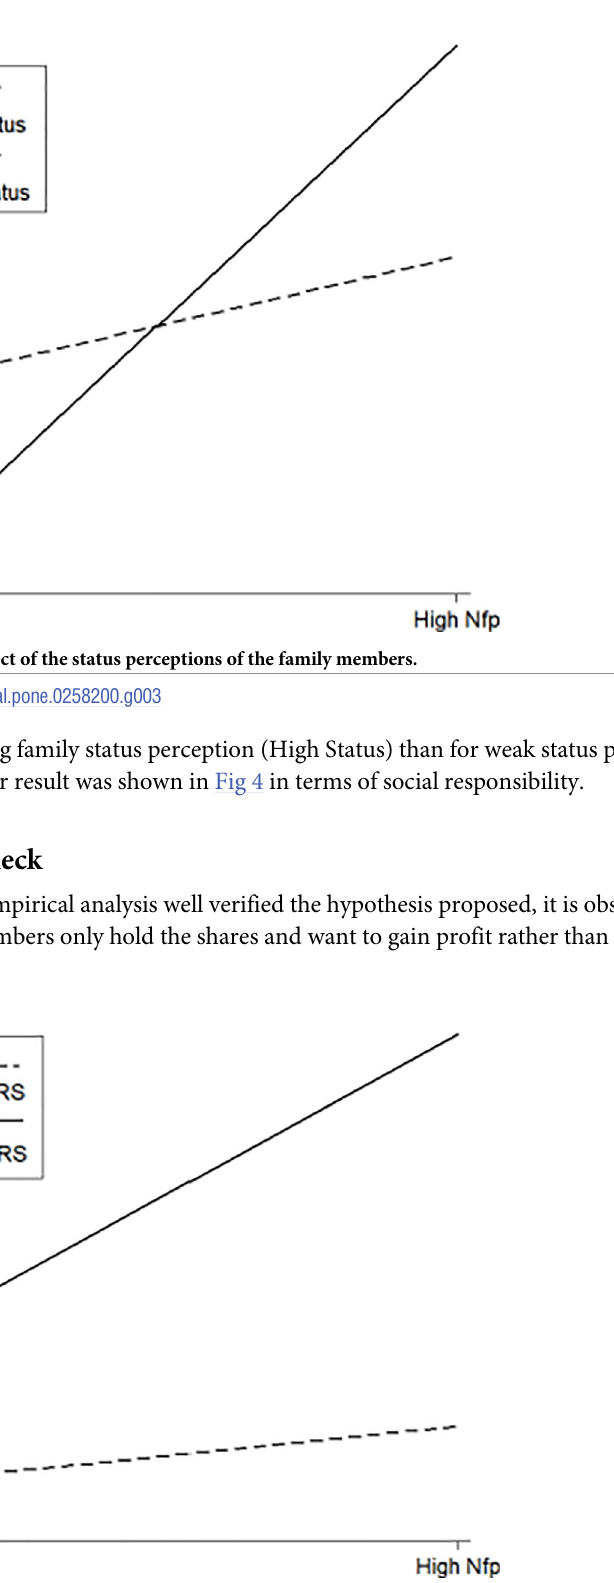
Fig 4. The moderating effect of the family social